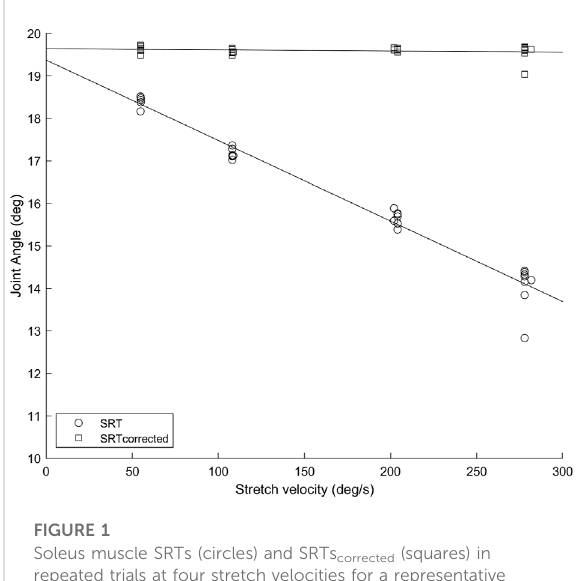
FIGURE 1 Soleus muscle SRTs (circles) and SRTs corrected (squares) in repeated trials at four stretch velocities for a representative participant. The error caused by not considering the SR latency increases with increasing velocity, as the amount of angular displacement between the SR onset and the SR EMG onset is